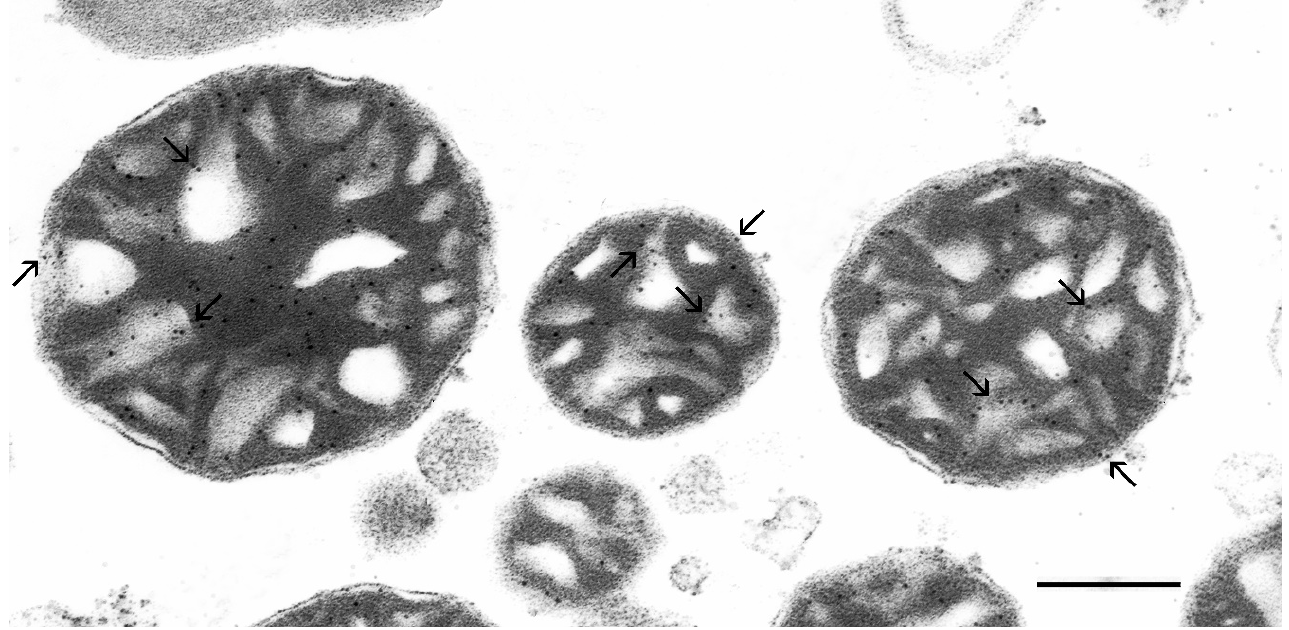
Figure 7. Ultrastructural localization of the group IV Ca 2+ (Sr 2+ )-dependent cytosolic phospholipase A 2 (cPLA 2 ) in isolated rat liver mitochondria. Mitochondria were incubated with specific antibodies against cPLA 2 and secondary antibodies labeled with 10 nm colloidal gold nanoparticles. Black granules (shown by the arrows) are the binding sites for the antibodies to the target proteins. The scale bar is 0.25 µm.